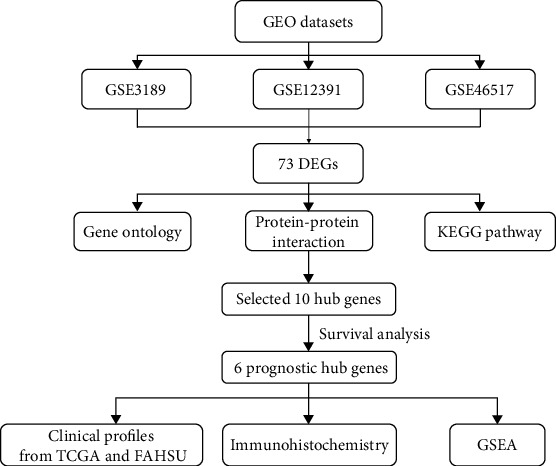
Flowchart of bioinformatics analysis. DEGs: differentially expressed genes; KEGG: Kyoto Encyclopedia of Genes and Genomes; GSEA: gene set enrichment analysis.